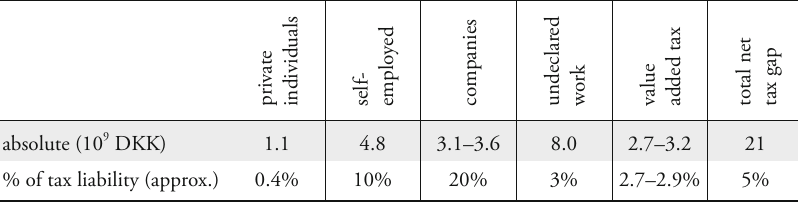
Table 3: Summary of the Bottom-Up Net Tax Gap in Denmark for the Tax Year